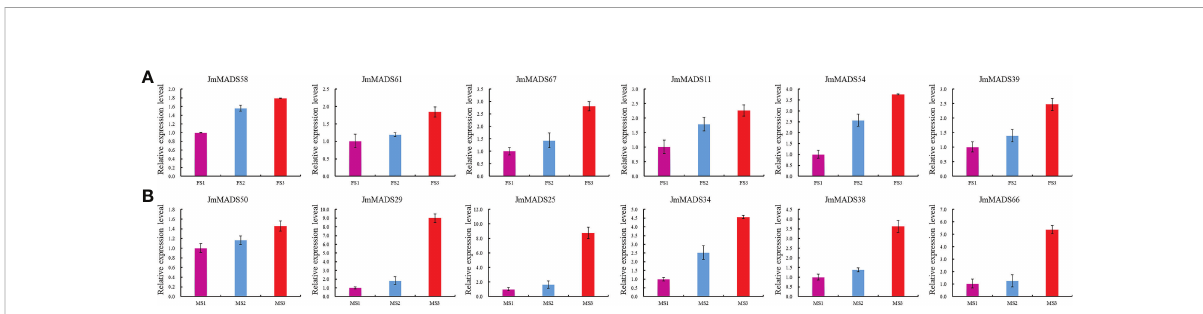
FIGURE 7 The expression levels of 12 JmMADS genes during the development of female and male fl owers. (A) The expression of 6 JmMADS genes in female fl owers using RT − qPCR. (B) The expression of 6 JmMADS genes in male fl owers using RT − qPCR. The y-axis shows the gene expression levels detected by RT − qPCR. The x-axis represents the tissues of different stages. The error bars represent standard error. The values are the mean ± standard deviation of three replicates.